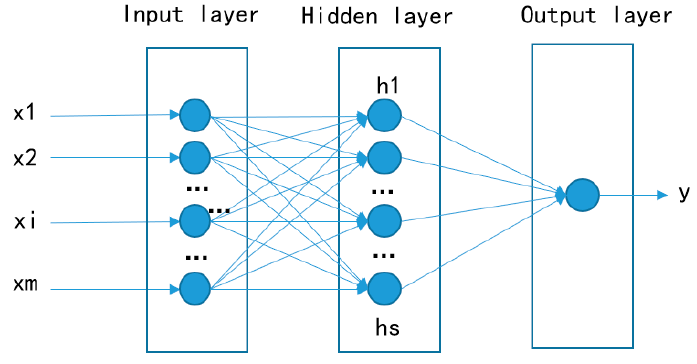
Figure 2. Construction of applied multi-layer perceptron (MLP) in this study.